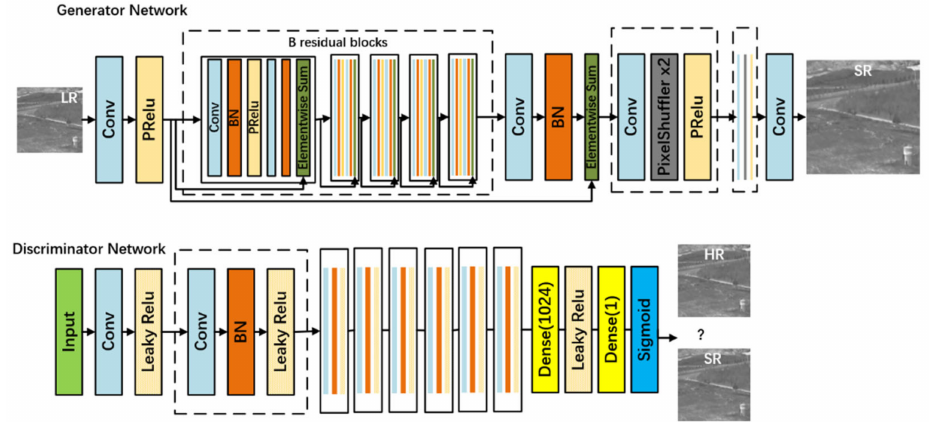
Figure 2. SRGAN generator G and discriminator D